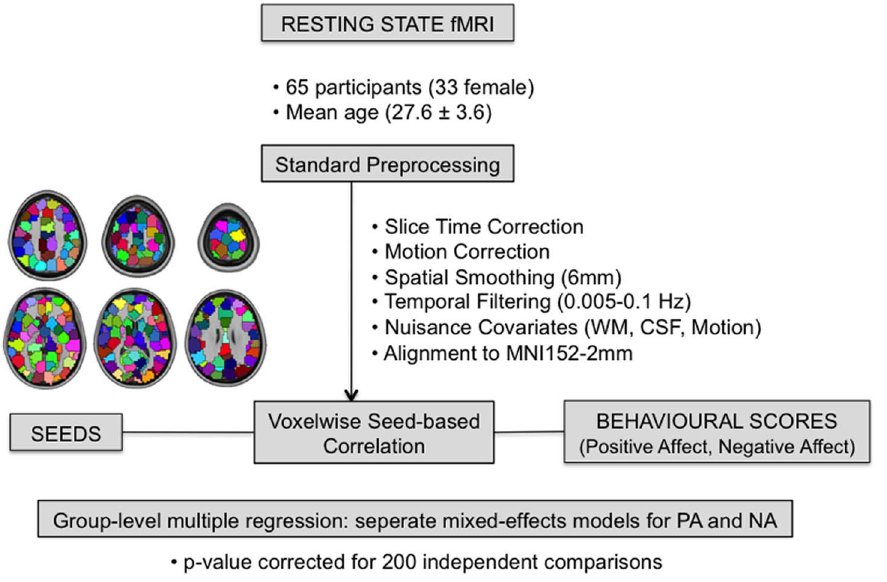
Figure 3. Data processing path. Following standard pre-processing of the resting state fMRI data, connectivity was calculated between the time courses of each of the 200 functional seeds and all the voxels in the brain. These connectivity scores were correlated with PA and NA scores in separate analyses, which were followed by a group-level multiple regression and two conjunction analyses.